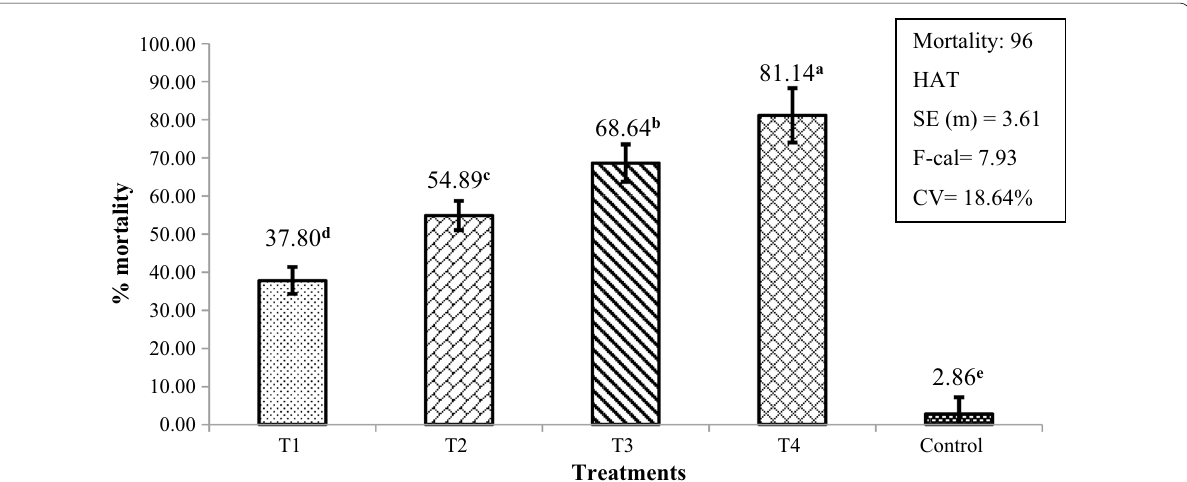
Fig. 6 Per cent mortality of aphids in controlled polyhouse conditions after treatment with spore suspension of Alternaria alternata VLH1